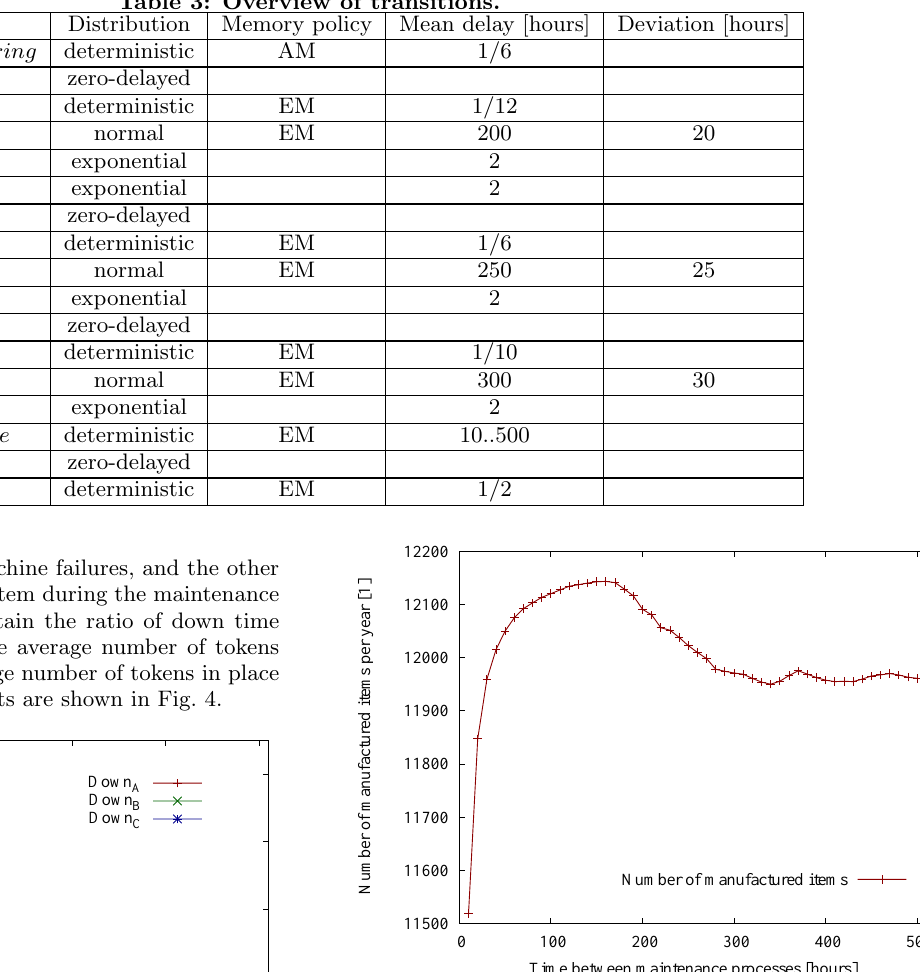
Table 3: Overview of transitions.